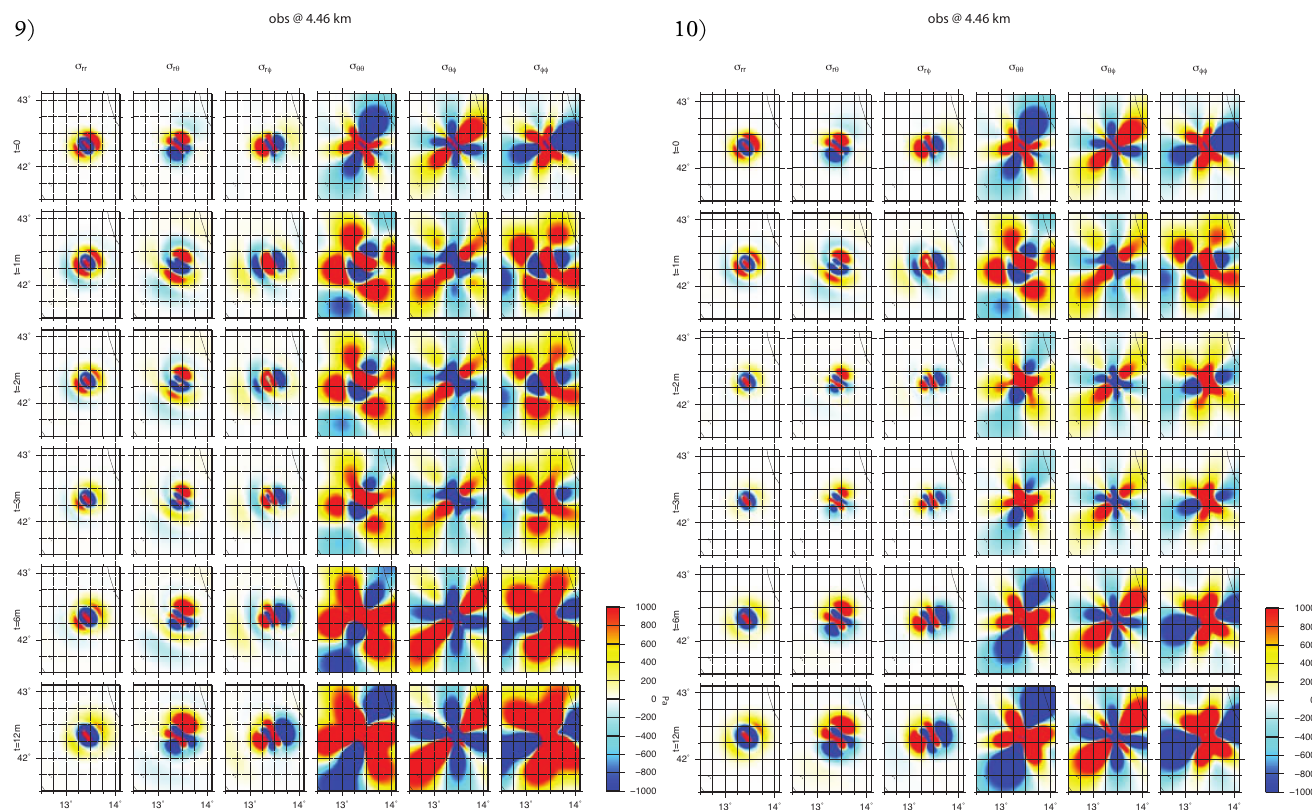
Figure 9. As for Figure 5, with rheological model Mod3 (see Table 2), and the observer located at 4.46 km in depth. Figure 10. As for Figure 5, with rheological model ModB (see Table 2), and the observer located at 4.46 km in